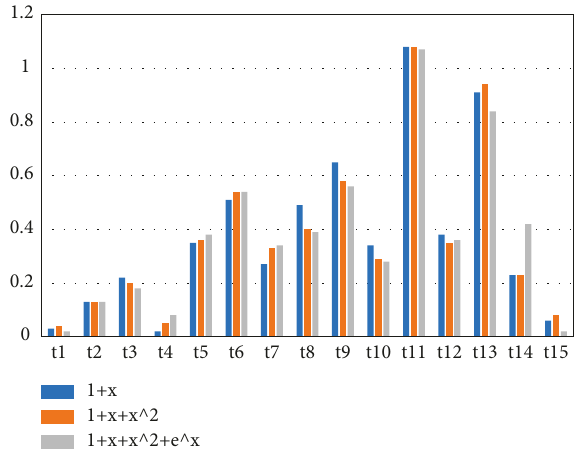
Figure 8: Relative